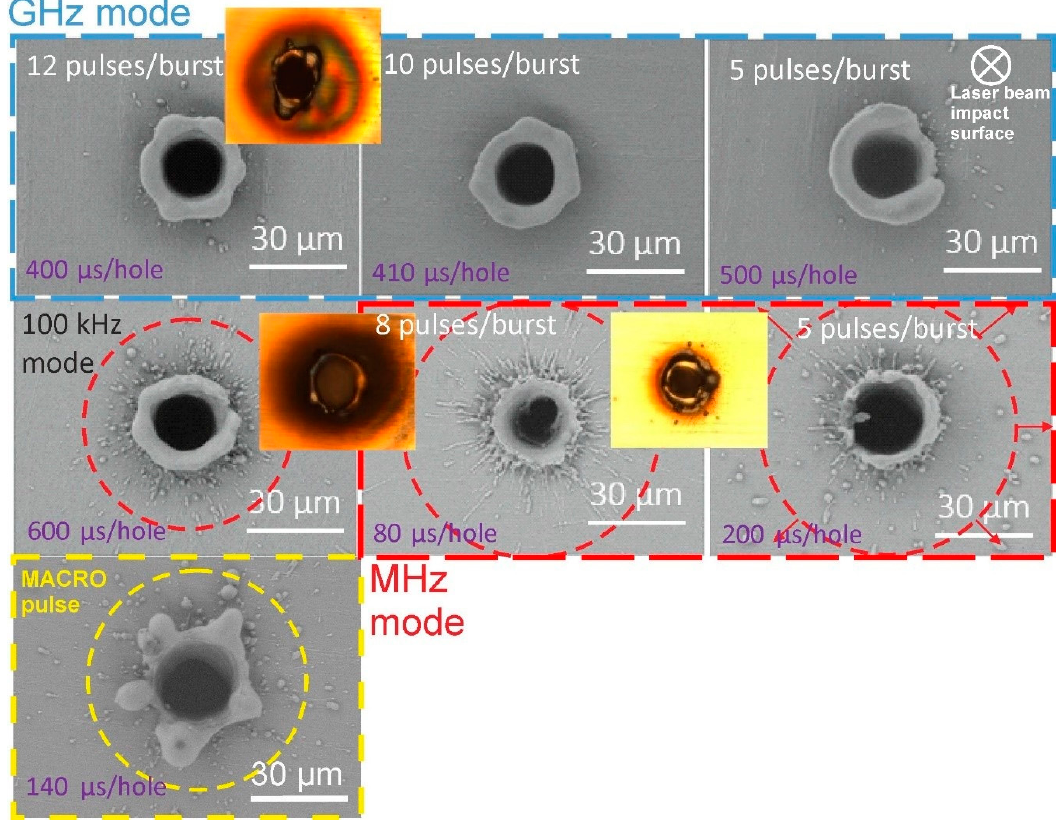
Figure 3. SEM images of the material surface when through-holes are produced in a 20 µ m thick sample for di ff erent burst pulse modes, which are indicated by di ff erent color borders namely blue for GHz, red for MHz, yellow for MACRO, and for comparison, the 100 KHz case is presented without the border. The laser power was set to 5 W in all the cases and the time needed to produce these through-holes is indicated in the left bottom corner for each image. The optical microscope images (do not correspond to the same SEM image) are presented next to SEM images.